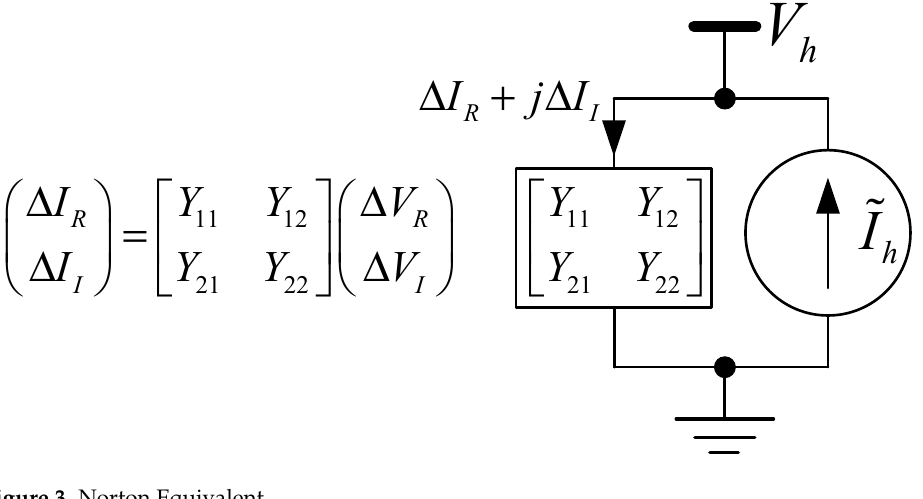
Figure 3. Norton Equivalent.